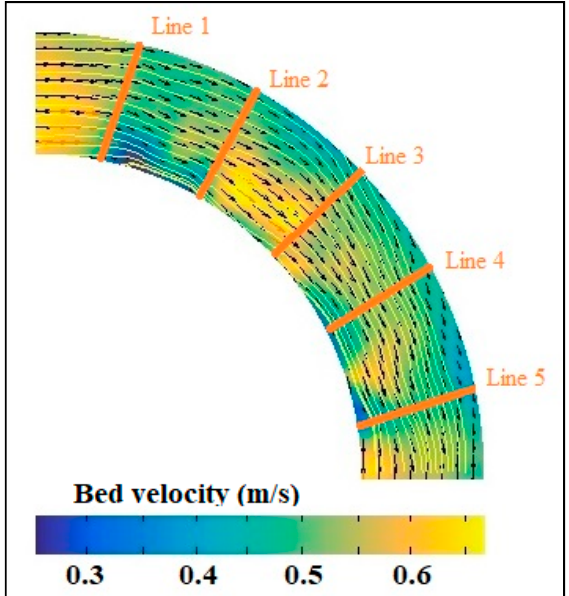
Figure 7. Estimation of U m for different bed weights by fixing the blade angle at 60º.